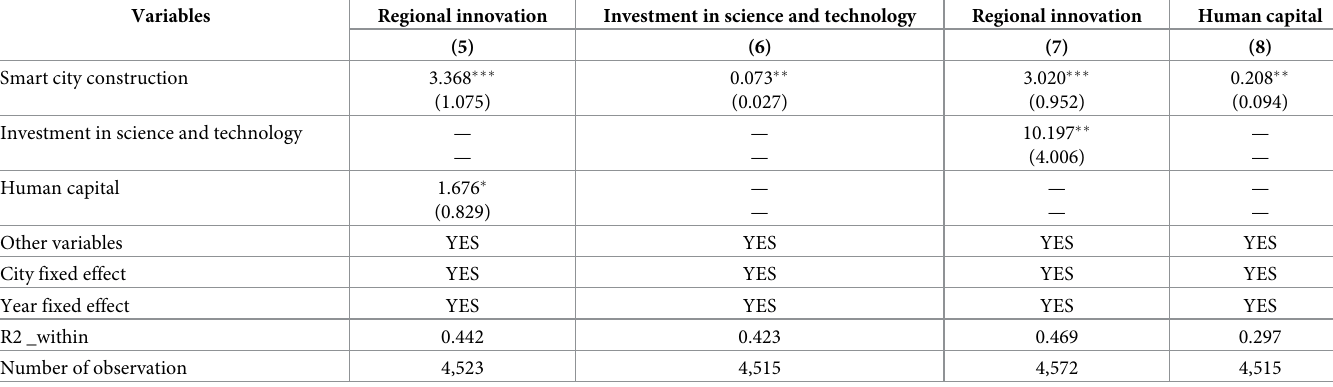
Table 3. Transmission pathway